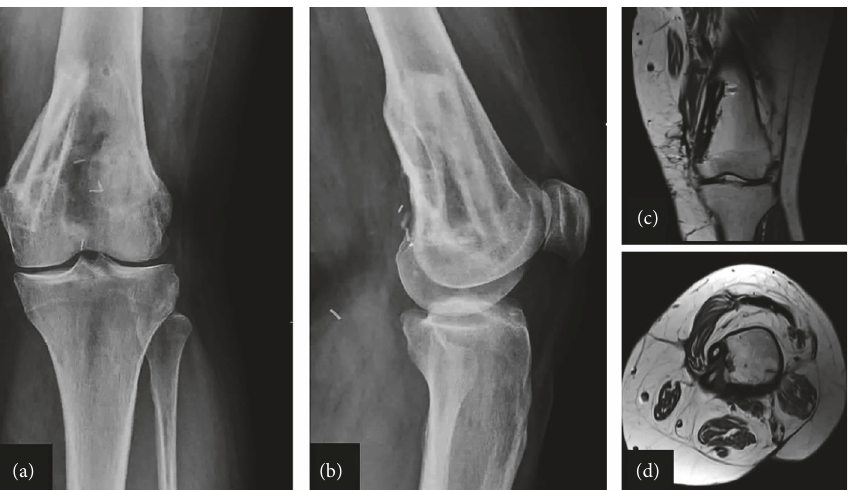
Figure 11: Anteroposterior (a) and lateral (b) radiographs of the knee 13months postoperatively showing incorporation of the fibula autografts with no signs of recurrence. Magnetic resonance imaging of the distal femur (sagittal (c) and axial (d) views) showing the distal femur with the fibula autografts with no signs of recurrence, infection, or autograft